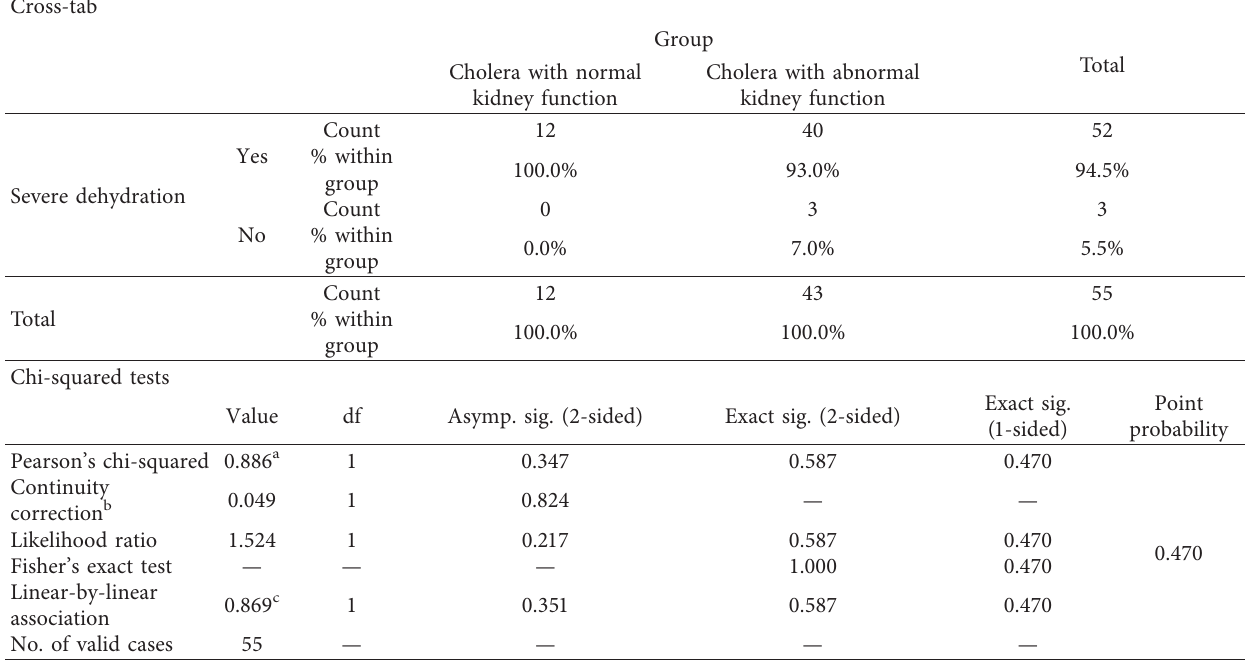
Table 3: Correlation of dehydration with